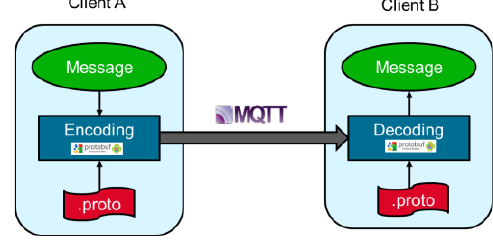
Fig. 3. Google Protocol buffers.